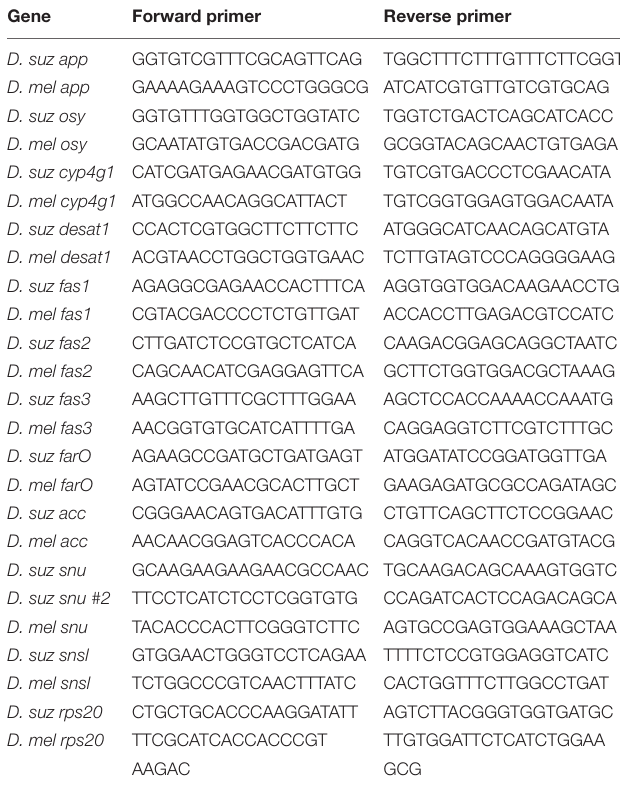
TABLE 1 | Sequences of primers for qPCR used in this study. Gene Forward primer Reverse